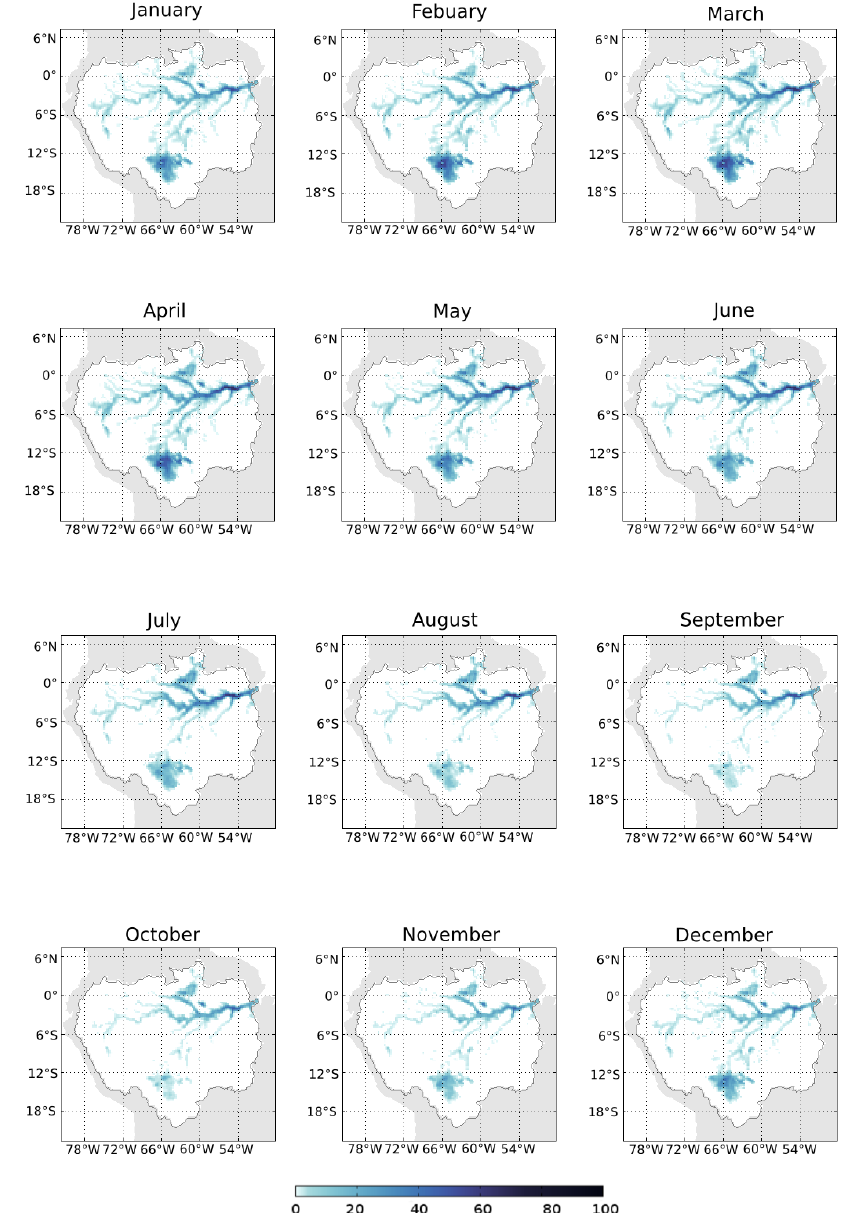
Figure 7. Monthly average of the SWAF product from 2010–2015 at V-polarization and at 32 ◦ ± 5 ◦ incidence